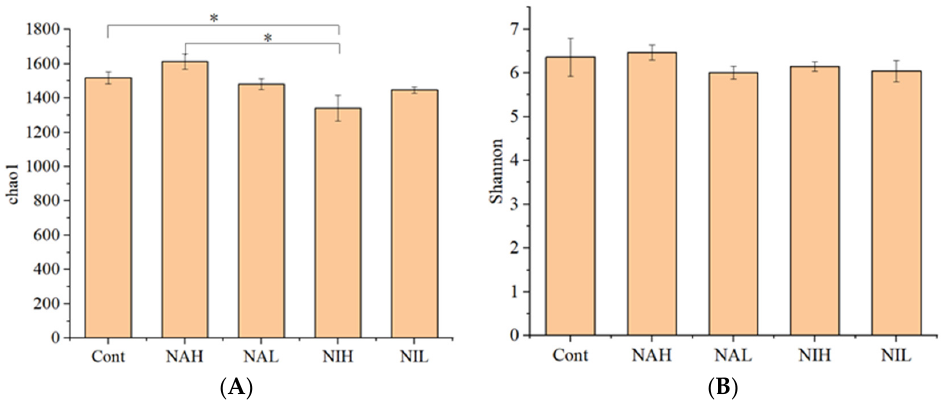
Figure 1. Alpha diversity of biofilms from the different treatments. ( A ) Richness, indicated by the Chao1 index. ( B ) Diversity, indicated by the Shannon index. Cont: control; NAH: 1 mg/L sodium selenate; NAL: 100 µg/L sodium selenate; NIH: 1 mg/L sodium selenite; NIL: 100 µg/L sodium selenite. * represents that there is a significant difference between these two groups.